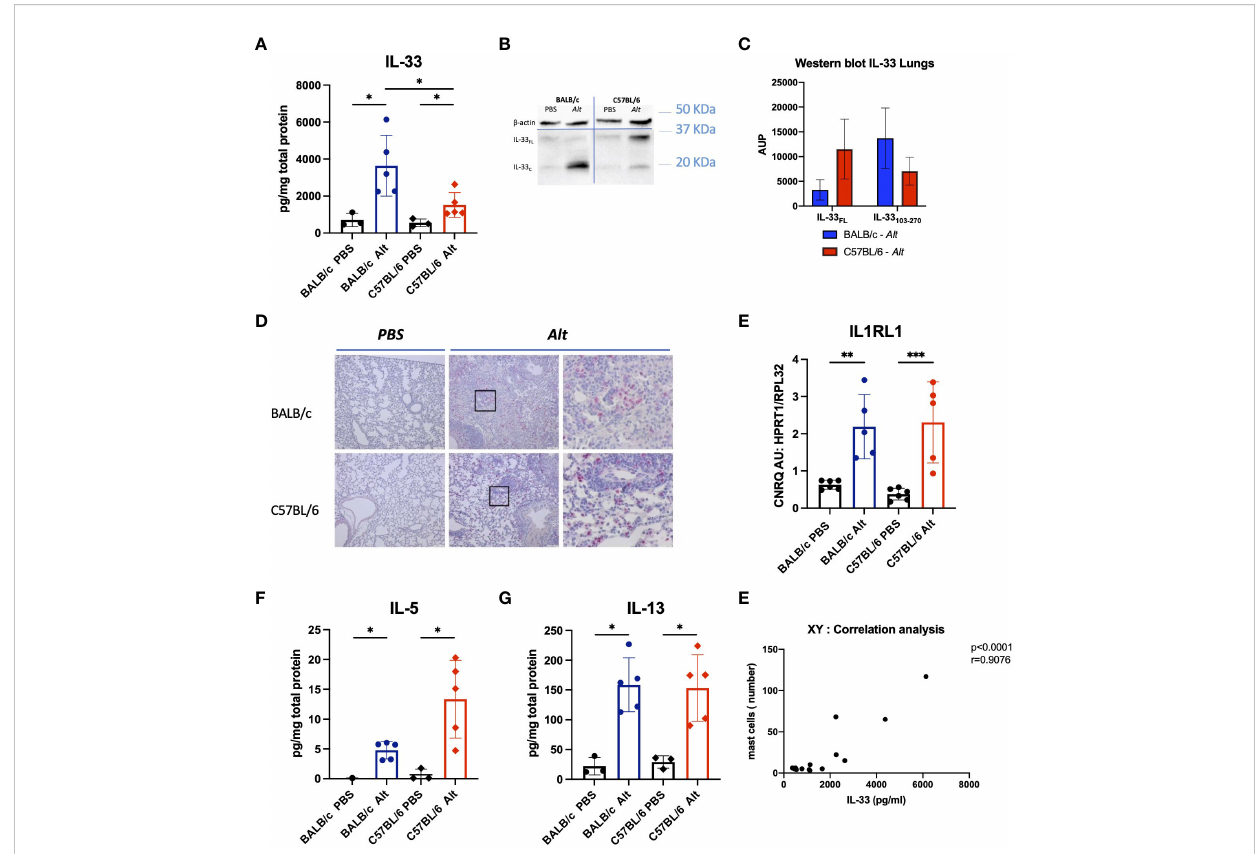
FIGURE 2 The analysis of cytokine response in the lungs of mice with intratracheal applications of 20 µ g of Alt extract and PBS-treated controls. The levels of IL-33 (A) in the lung homogenates were measured by Luminex. Full-length IL-33 (IL-33 FL ) and cleaved forms (IL-33 C ) were analysed by western blotting and one representative blot is shown (B) and area under the peak (AUP) was quanti fi ed using ImageJ software (C) . Representative images of IL-33 immunostaining in the lungs of C57BL/6 and BALB/c treated with PBS or the Alt extract for six times every 48 hours (D) . IL1rl1 gene expression levels analysed in lungs by RT-qPCR (E) . The levels of IL-5 (F) , IL-13 (G) in the lung homogenates were measured by Luminex. The data are presented as scatter plot with a bar ± standard deviation (S.D). Statistical signi fi cance between the groups was determined by one-way ANOVA with Dunn ’ s test for multiple comparisons. N=4-6 per group. *p < 0.05, **p < 0.01, ***p <